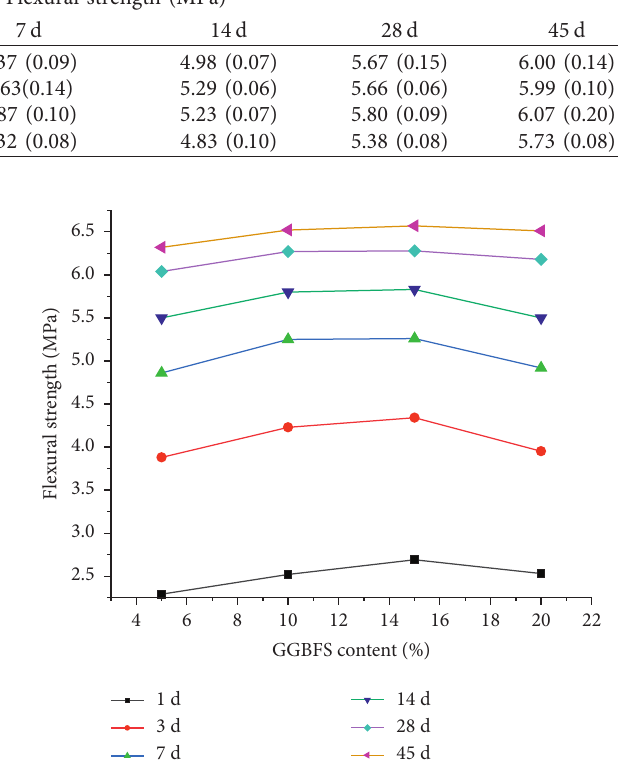
Figure 4: Influence of W/B ratio on concrete flexural strength.